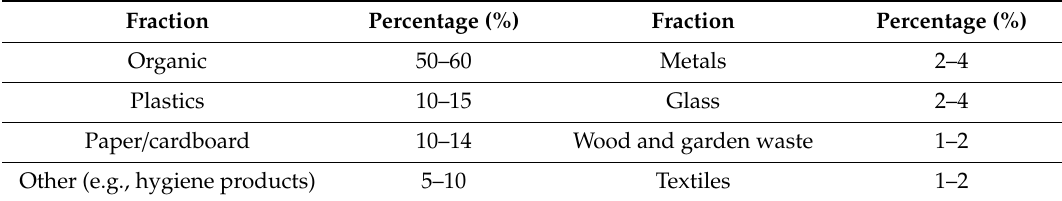
Table 1. Waste fraction divisions in Jordan [18].